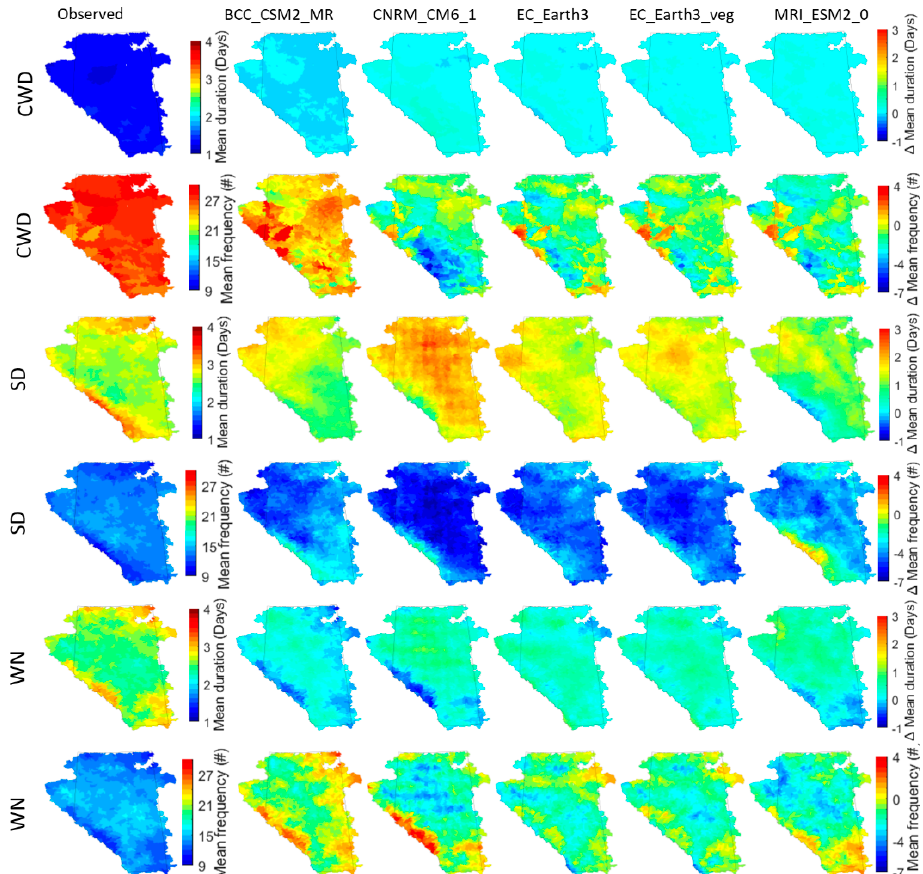
Figure 5. Spatial distribution of mean annual duration and frequency of CWD, SD, and WN for the 1983–2014 period for 2255 sub-basins. The first column in the left represents the magnitude of duration and frequency based on observed data and rest four columns indicate the difference between GCM simulations and observation (delta changes). A positive delta mean frequency and duration indicate an overestimation by GCMs.